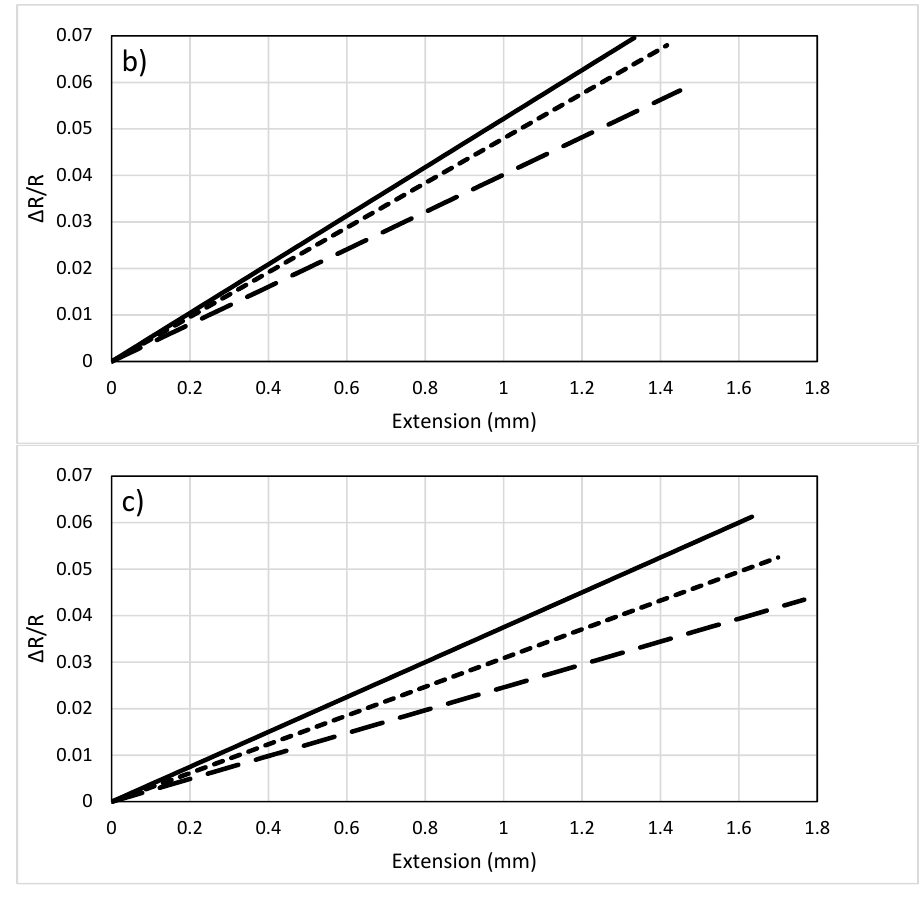
Figure 7. Effect of length on Δ R/Ro for carbon fiber sensors: ( a ) 1 K, ( b ) 3 K, ( c ) 6 K;